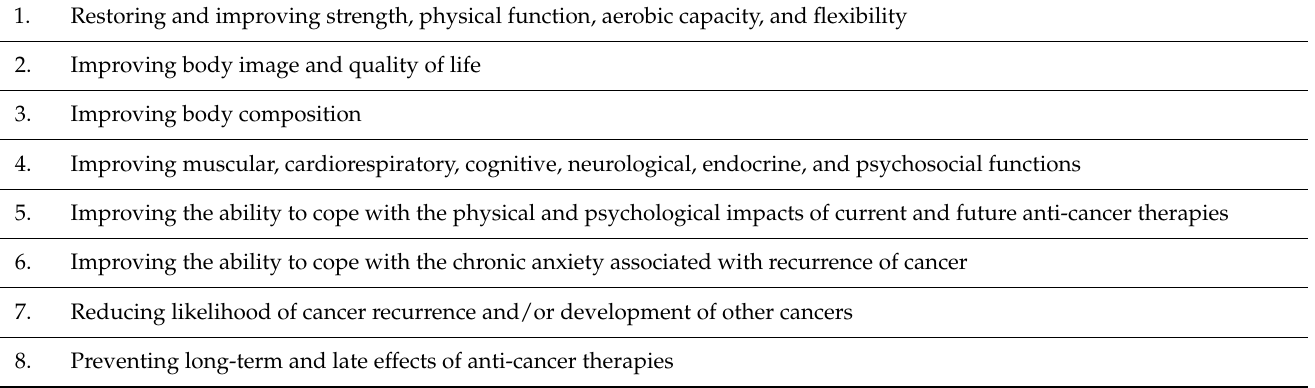
Table 5. Objectives of Exercise Prescription in Breast Cancer Survivors. Adapted from Schmitz et al.